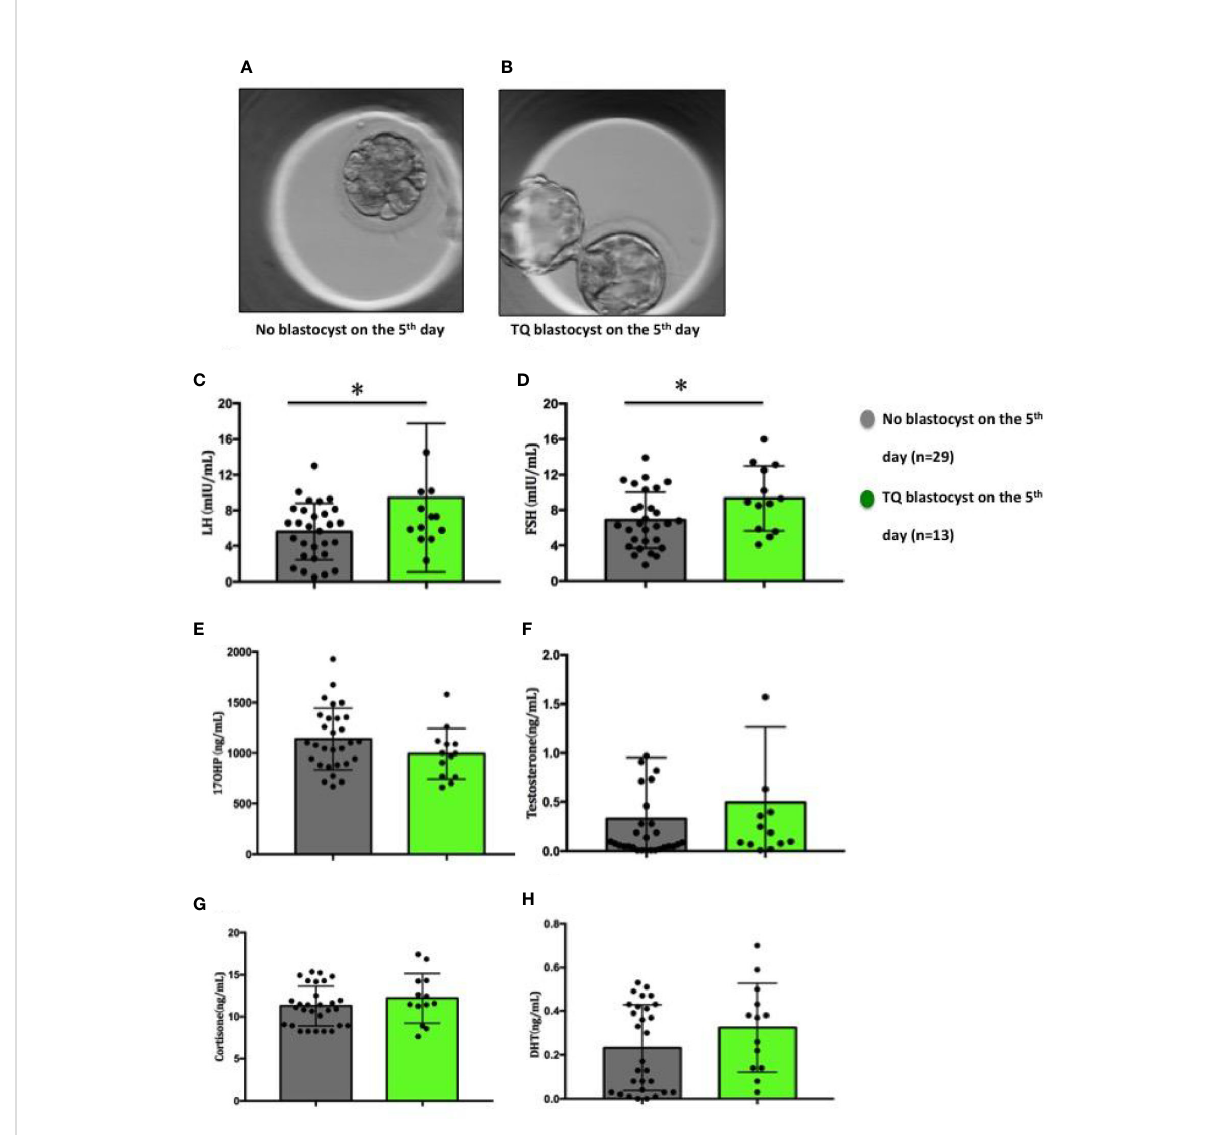
FIGURE 3 Figures of embryos and distribution of steroid and gonadotropic hormone concentrations in follicular fl uid in relation to the embryo development on the 5 th day. (A) No blastocyst on the 5 th day; (B) TQ blastocyst on the 5 th day; (C) LH; (D) FSH; (E) 17-OHP; (F) Testosterone; (G) Cortisone; (H) Dihydrotestosterone. Comparison between groups was performed using Mann-Whitney U test. *p <